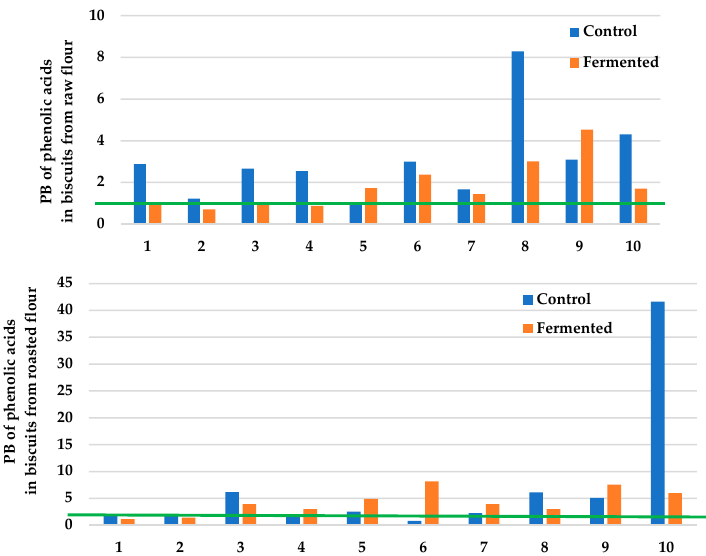
Figure 1. Potential bioaccessibility (PB) of phenolic acids from biscuits obtained from raw and roasted buckwheat flour. PB > 1: high bioaccessibility; PB < 1: low bioaccessibility. Phenolic acids: chlorogenic (1); p-coumaric (2); sinapic (3); ferulic (4); t-cinnamic (5); syringic (6); vanillic (7); isovanillic (8); protocatechuic (9); and ca ff eic (10).